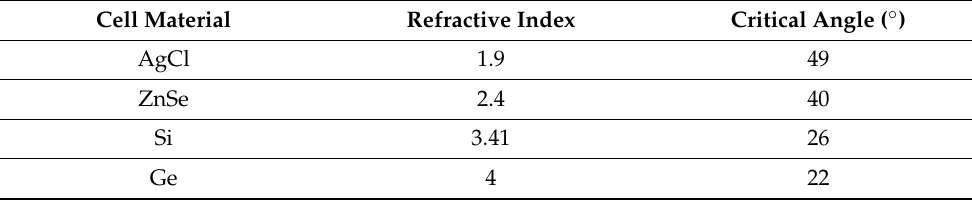
Table 1. Various common materials used to cover the prism surface to reduce critical